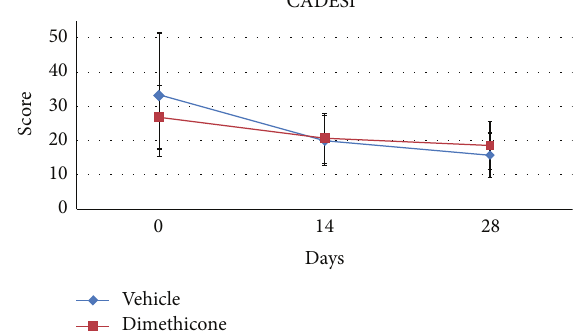
Figure 2: Mean total canine atopic dermatitis extent and severity Index (CADESI) scores as determined by the investigator. Error bars indicate ± standard deviation. ANOVA showed a significant effect of time with day 0 > day 28. The total CADESI was decreased for both the vehicle group and the dimethicone group, over time.